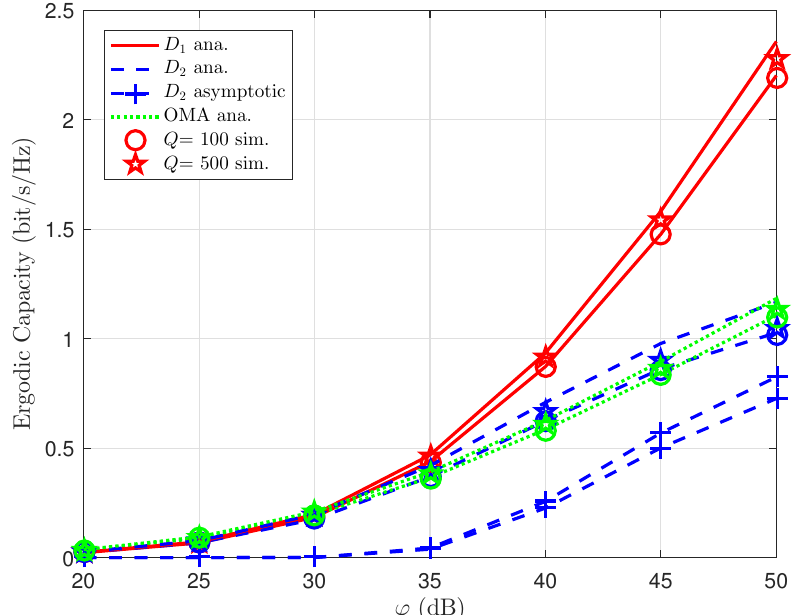
Figure 7. EC versus ϕ for different Q with G = K = 1000.